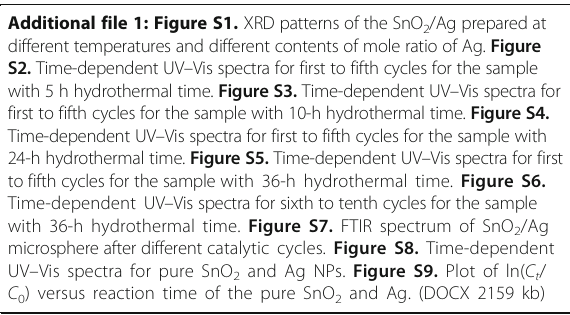
Additional file 1: Figure S1. XRD patterns of the SnO 2 /Ag prepared at different temperatures and different contents of mole ratio of Ag. Figure S2. Time-dependent UV – Vis spectra for first to fifth cycles for the sample with 5 h hydrothermal time. Figure S3. Time-dependent UV – Vis spectra for first to fifth cycles for the sample with 10-h hydrothermal time. Figure S4. Time-dependent UV – Vis spectra for first to fifth cycles for the sample with 24-h hydrothermal time. Figure S5. Time-dependent UV – Vis spectra for first to fifth cycles for the sample with 36-h hydrothermal time. Figure S6. Time-dependent UV – Vis spectra for sixth to tenth cycles for the sample with 36-h hydrothermal time. Figure S7. FTIR spectrum of SnO 2 /Ag microsphere after different catalytic cycles. Figure S8. Time-dependent UV – Vis spectra for pure SnO 2 and Ag NPs. Figure S9. Plot of ln( C t / C 0 ) versus reaction time of the pure SnO 2 and Ag. (DOCX 2159 kb)